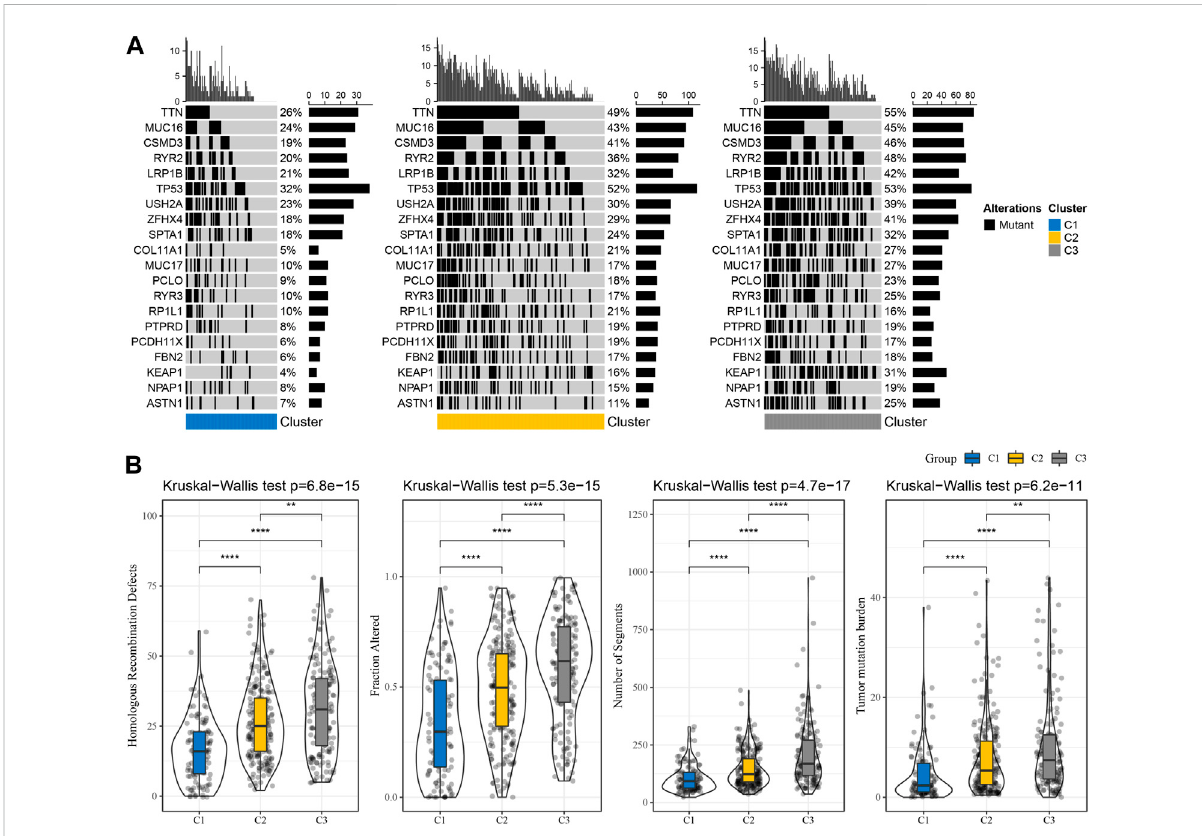
FIGURE 2 TCGA cohort data on the frequency of gene mutations and genomic changes in various subtypes. (A) Somatic mutation analysis (Fisher ’ s exact test) for different molecular subtypes; (B) Differences between different molecular subgroups in terms of homologous fraction altered, number of segments, recombination defects, and tumor mutation load. ** p < 0.01, **** p <